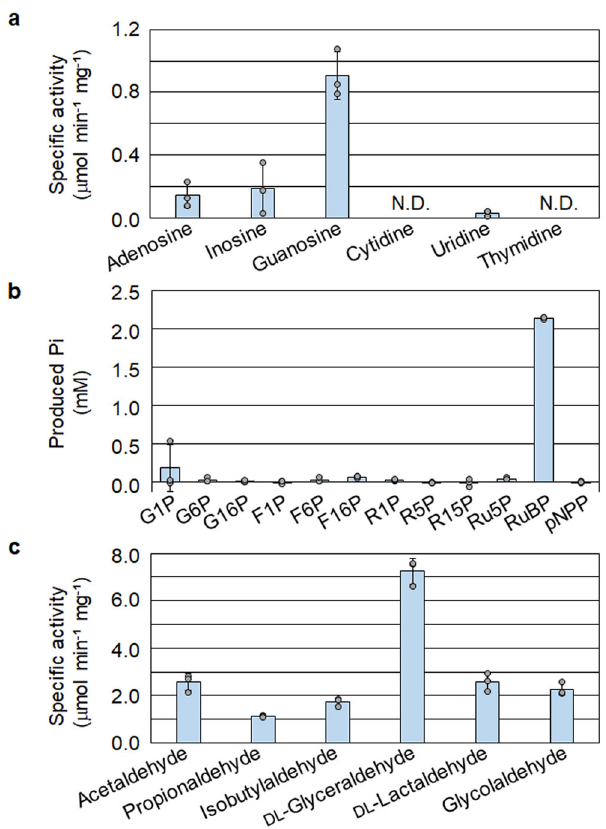
Fig. 4 Enzyme activity analyses of Hl -Urdpase1, Hx -HAD hydrolase, and Hx -FucA proteins. a Nucleoside phosphorylase activity of Hl -Urdpase1 was analyzed toward six nucleosides by quantifying the released nucleobases with HPLC. b Phosphatase activity of Hx -HAD hydrolase was investigated toward eleven sugar phosphates and pNPP by quantifying released phosphate with malachite green. G1P glucose-1-phosphate, G6P glucose-6- phosphate, G16P glucose-1,6-bisphosphate, F1P fructose-1-phosphate, F6P fructose-6-phosphate, F16P fructose-1,6-bisphosphate, R5P ribose-5- phosphate, Ru5P ribulose-5-phosphate, pNPP p -nitrophenylphosphate. c Aldolase activity of the Hx -FucA condensing DHAP and six aldehydes was examined by quantifying the residual DHAP after reactions with a coupling enzyme. The activities were calculated from n = 3 independent experiments. Error bars indicate standard